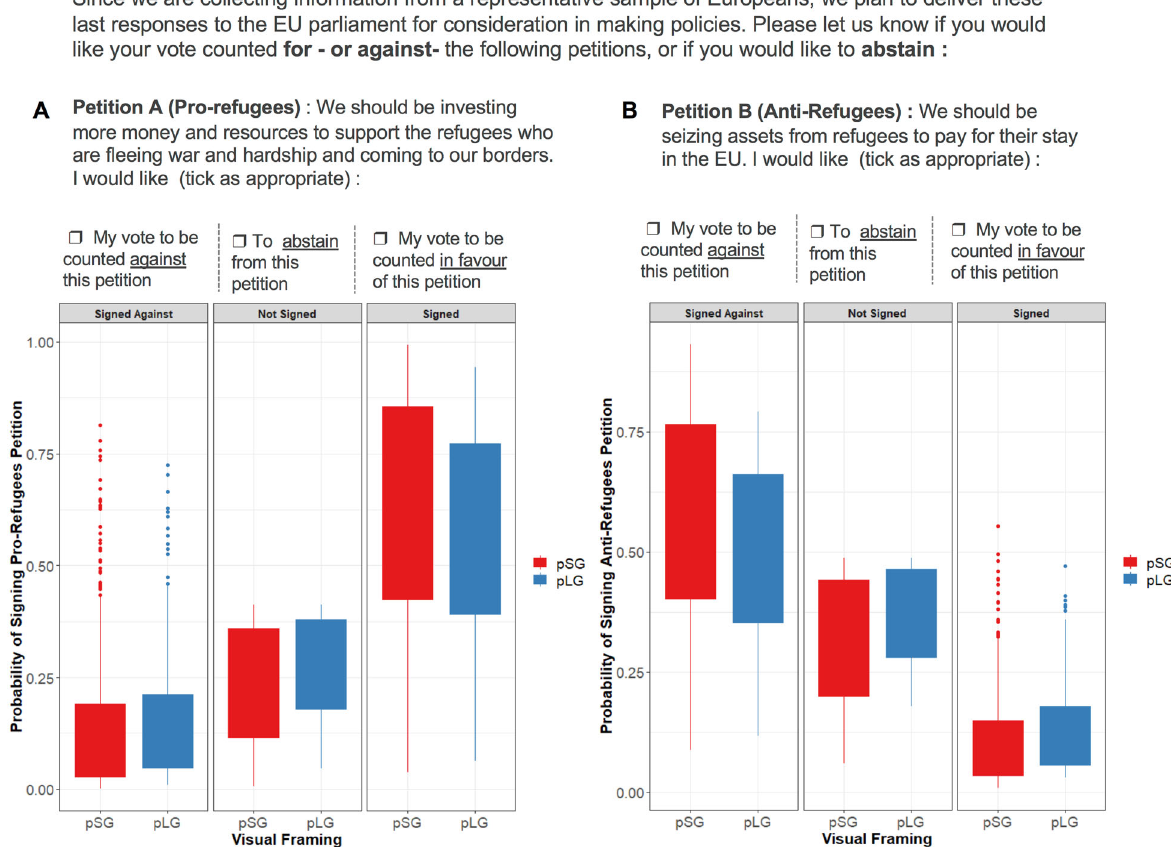
Fig. 3 Study 6 results. Plot with predicted values of the main effect of Visual Framing on the probability of signing a Pro-Refugees Petition or an Anti- Refugees Petition. See Tabular results in Supplementary